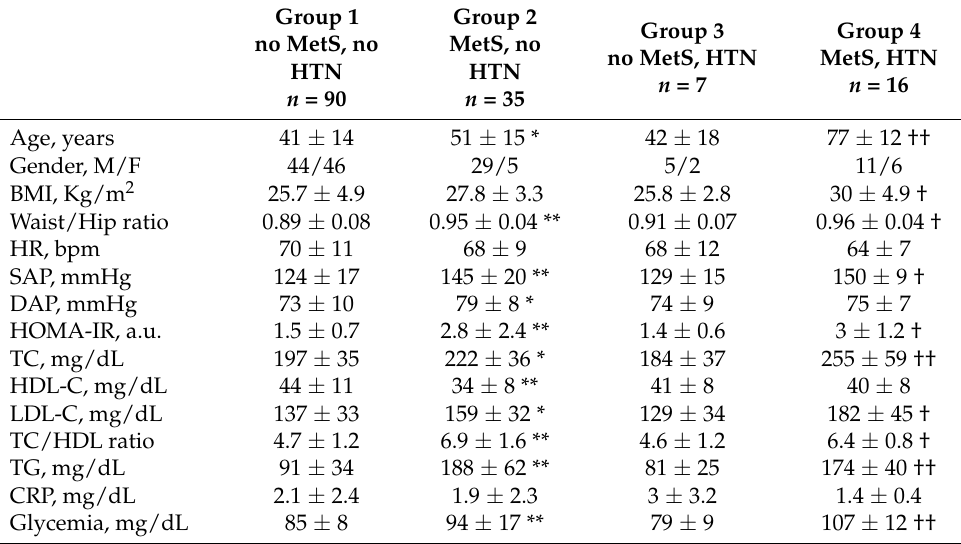
Table 3. Patient demographics, hemodynamic, and metabolic variables in the four subgroups defined by the absence/presence of metabolic syndrome (no MetS and MetS, respectively) and absence/presence of hypertension (no HTN and HTN, respectively).